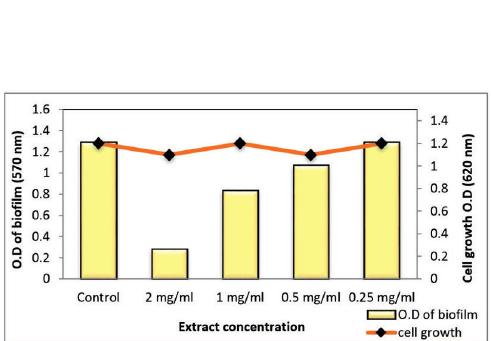
Fig. 10. Effect of sub-MICs of polyphenol fraction Z.